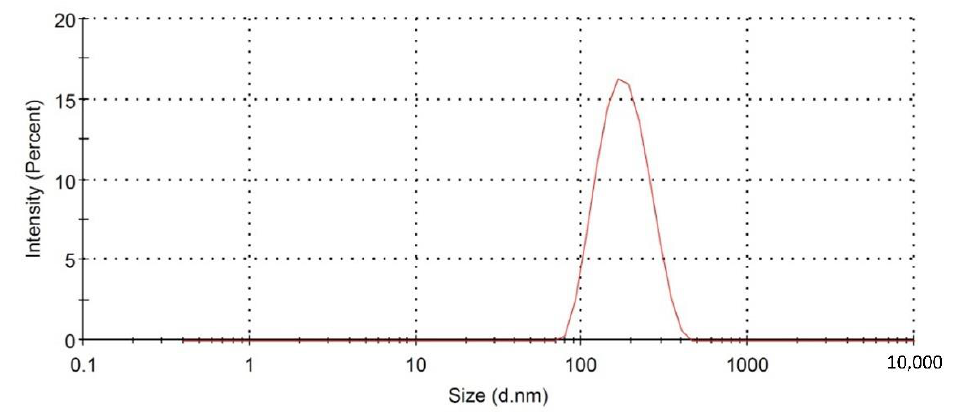
Figure 3. Particle size distribution of the optimized PIC-BZ.